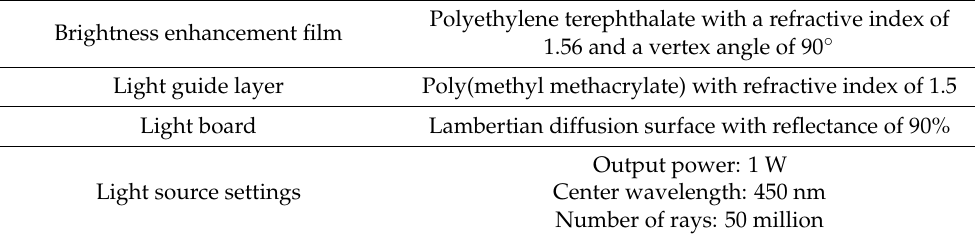
Table 1. Parameter settings for the simulation.